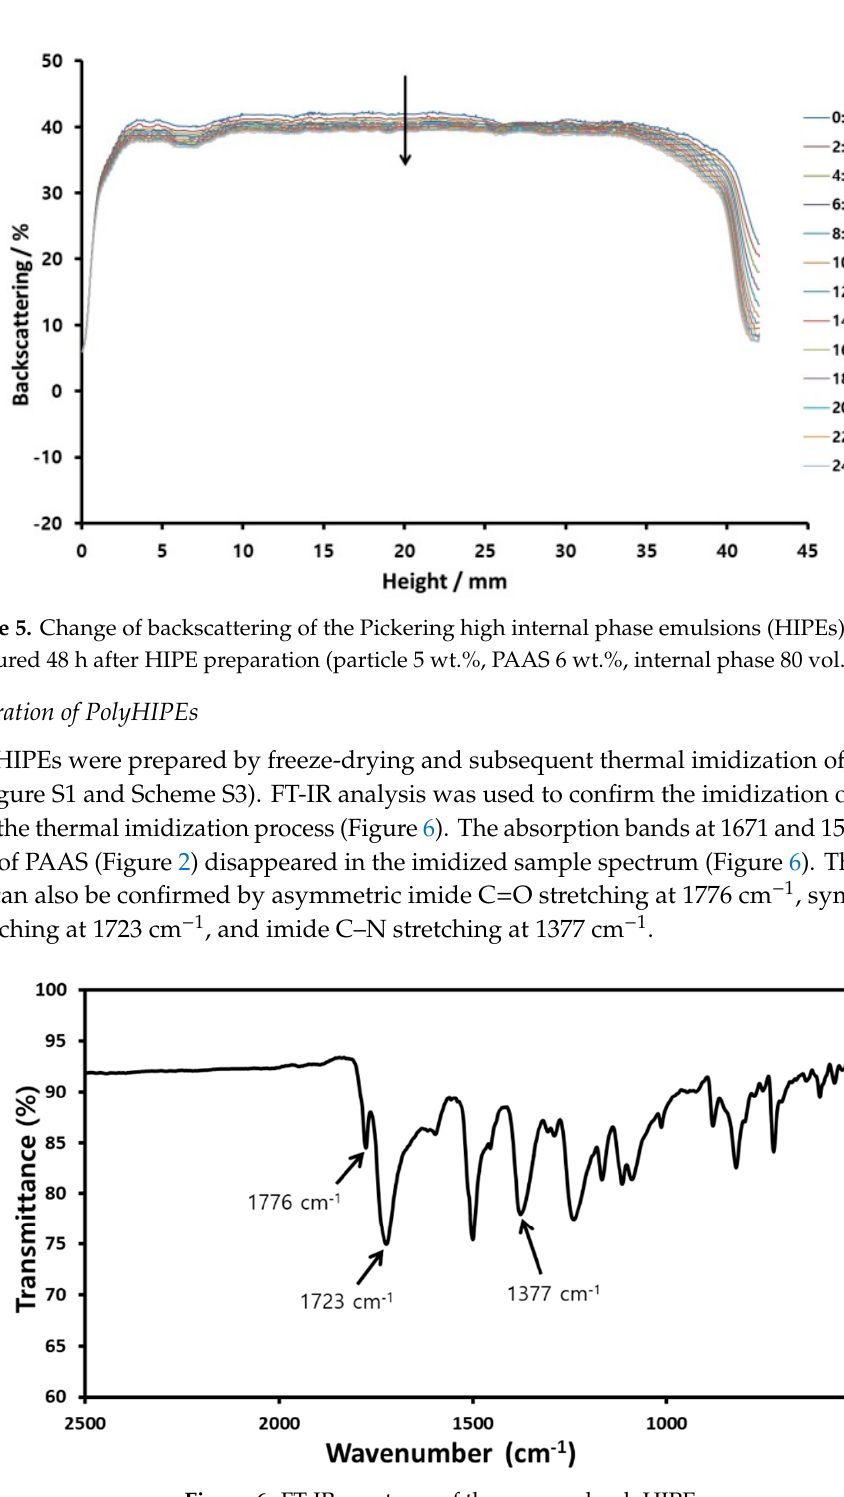
Figure 6. FT-IR spectrum of the prepared polyHIPE.